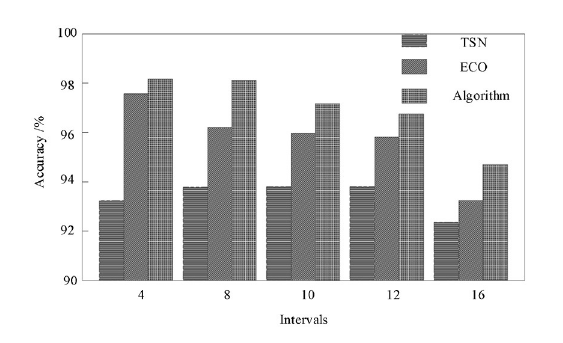
FIGURE5 Comparison of test